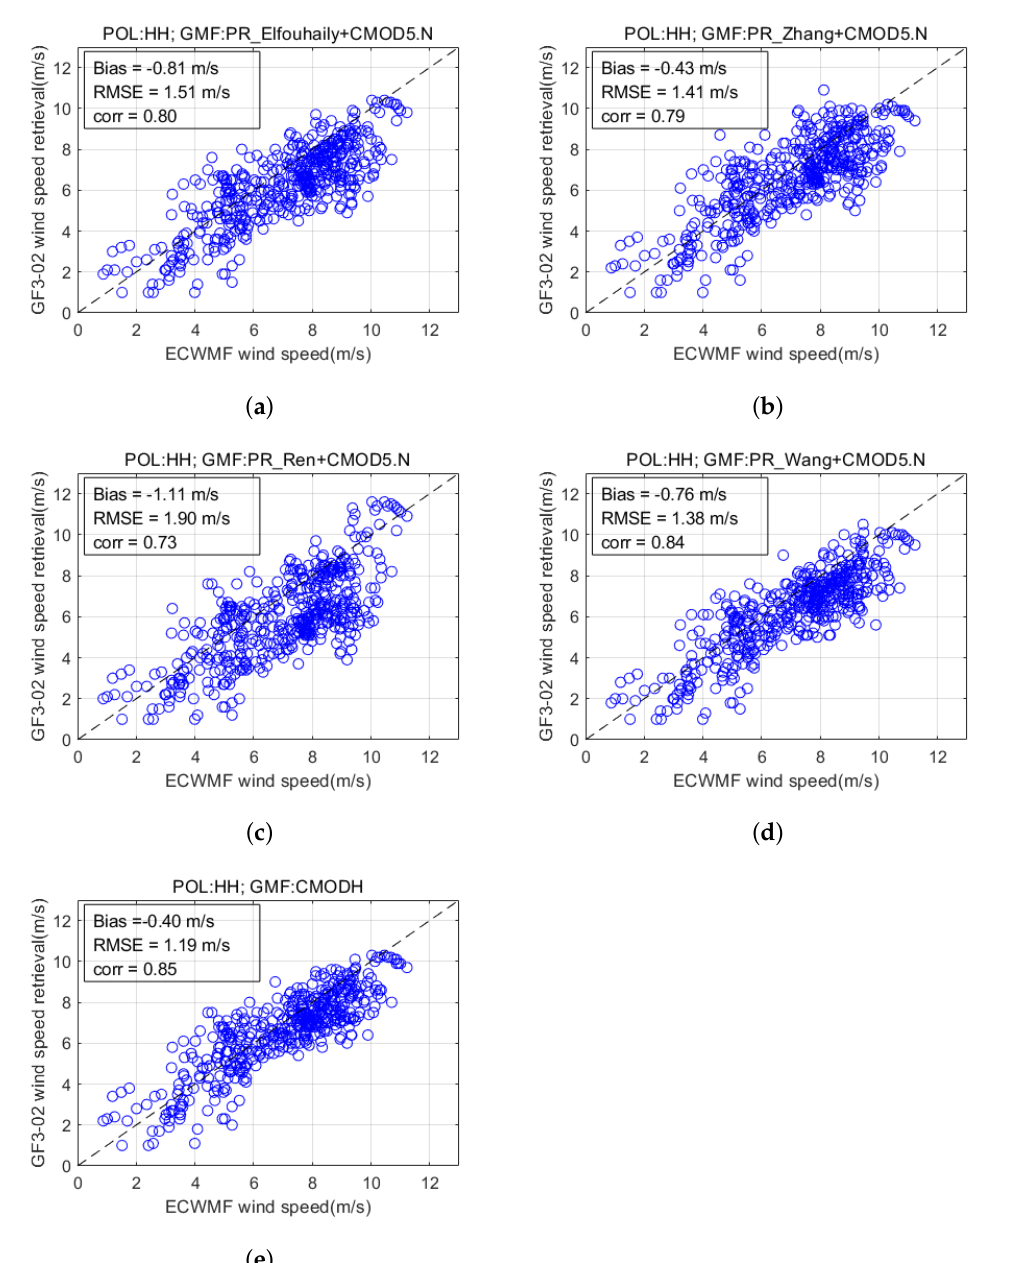
Figure 6. Comparison of wind speed retrieval results from GF3-02 HH polarization data based on ( a ) CMOD5.N+PR_Elfouhaily, ( b ) CMOD5.N+PR_Zhang, ( c ) CMOD5.N+PR_Ren, ( d ) CMOD5.N+PR_Wang, and ( e ) CMODH_HH and ERA5 wind